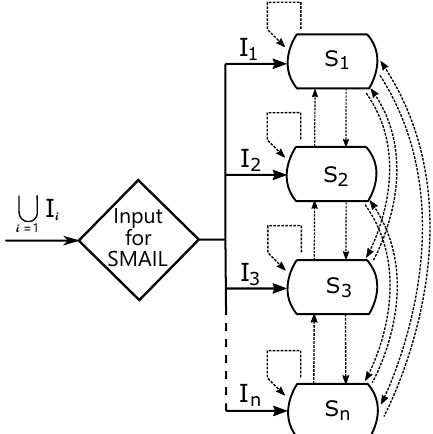
Figure 1. S MA il —A system of multiautomata with internal links.